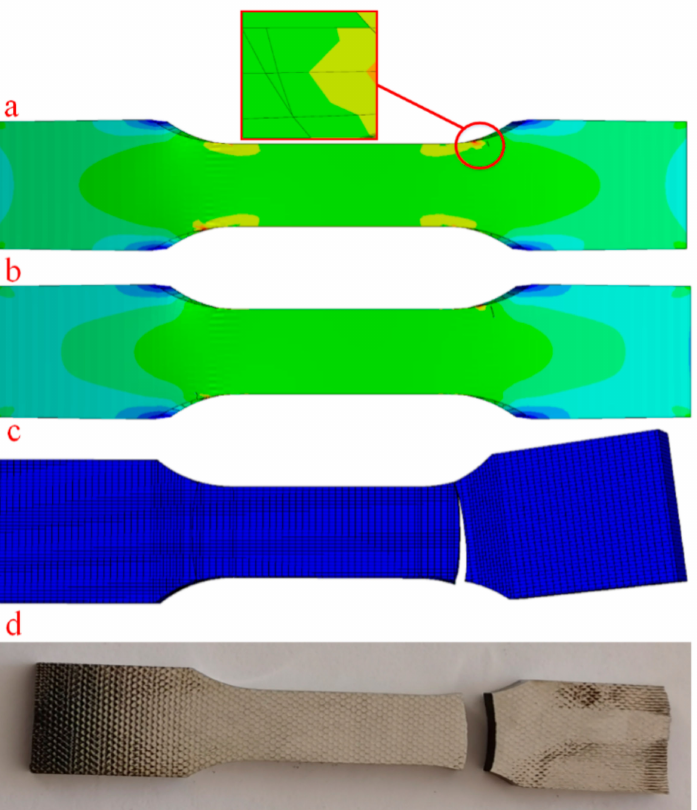
Figure 11. Comparison of fatigue crack growth process of quadrilateral bionic pit shape fatigue specimen model and test results: ( a ) initial crack initiation; ( b ) crack growth; ( c ) fatigue fracture; ( d ) fatigue fracture test